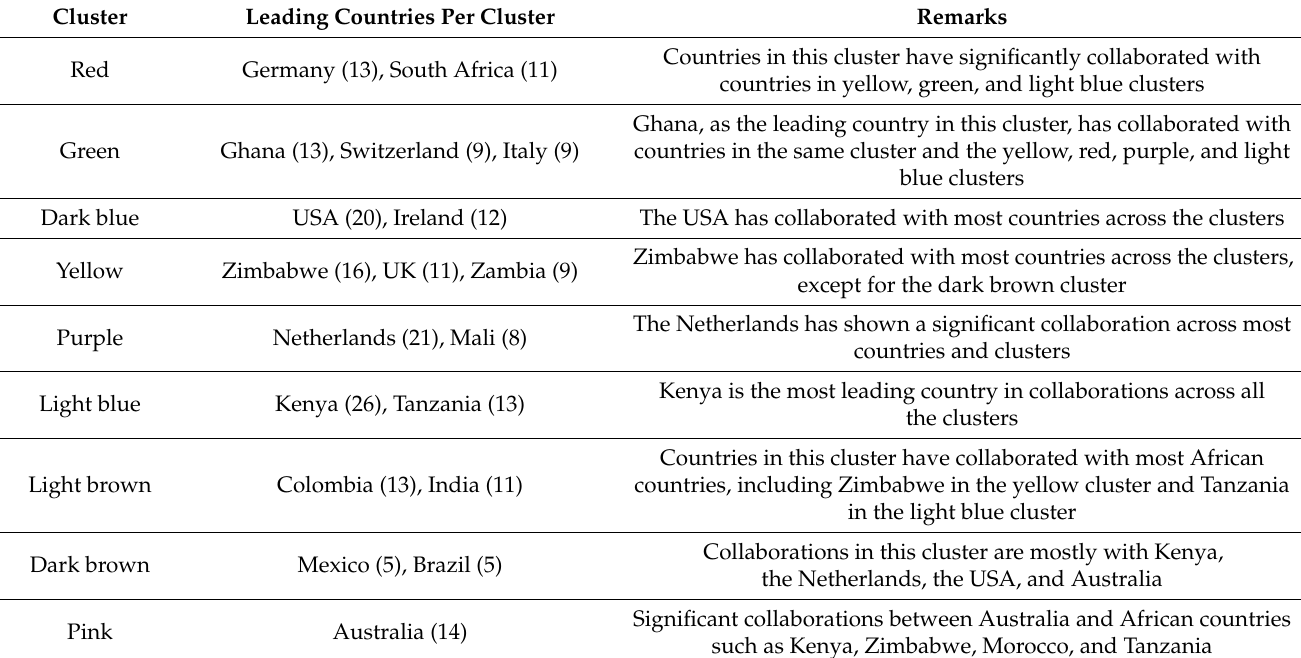
Figure 4. Countries’ collaboration network among different countries. Table 3. Clusters of countries’ collaborations in climate-smart agriculture research in Africa.